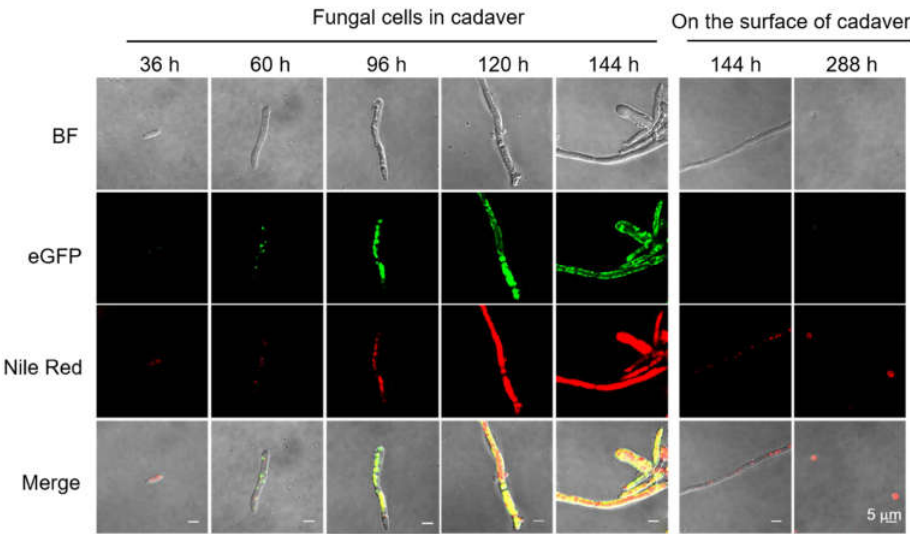
Figure 5. Representative images of BbPlin1 :: eGFP expression during the infection process using G. mellonella larvae as the host. Conidia from B. bassiana harboring the PbbPlin1 :: eGFP construct (5 μL/insect, 1 × 10 6 conidia/mL) was injected into the haemocoel of G. mellonella larvae. Images of fungal cells isolated at indicated time points and that include (i) fungal hyphal bodies in hemolymph (36 h), (ii) fungal hyphae formed post–host death inside the host (60–144 h), (iii) fungal hyphae formed on the surface of the cadaver (>144 h), and (iv) fungal conidia produced on the surface of the cadaver (288 h) were collected and counter–stained with Nile Red. Fungal conidia were harvested from BbPlin1::eGFP grown on PDA for 2 weeks at 26 °C. eGFP and Nile Red signals were visualized using confocal fluorescent microscopy as described in the Methods section. BF, bright field. Bar, 5 µ